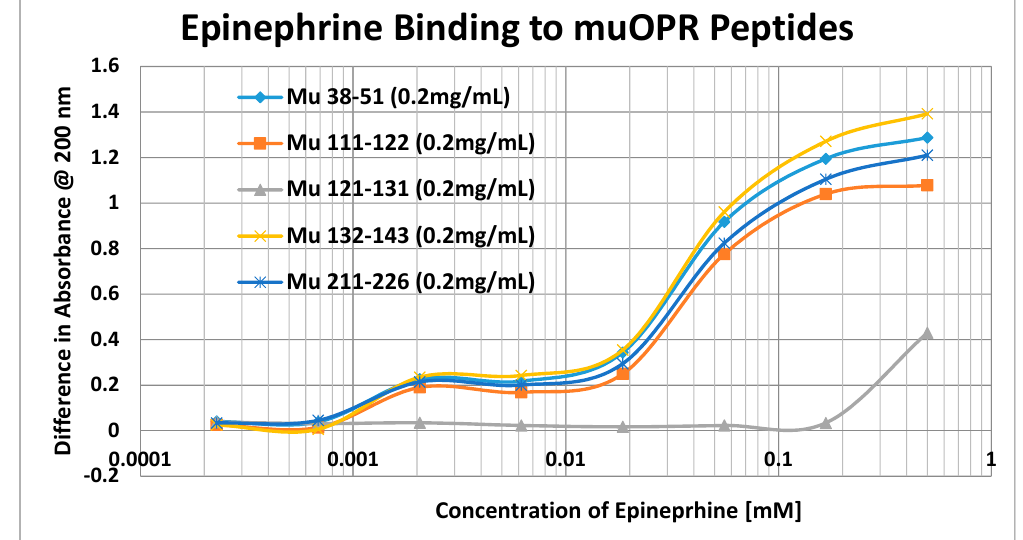
Figure 4. UV spectroscopic study of epinephrine binding to mu opioid receptor (muOPR) peptides derived from the extracellular loop and adjacent transmembrane regions (see Figure 1).